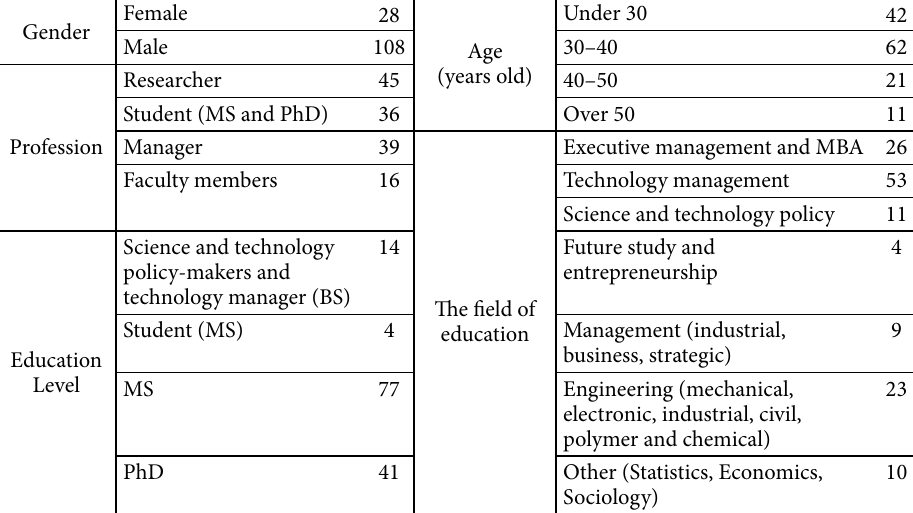
Table 5. Population demographic information (electronic questionnaire) Gender